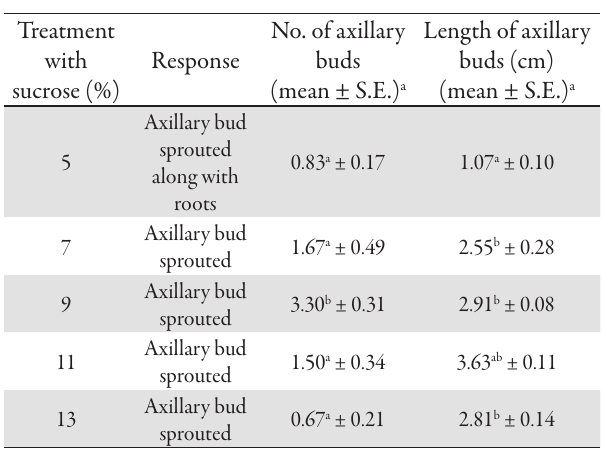
Tab. 6. Effect of ½ strength MS medium supplemented